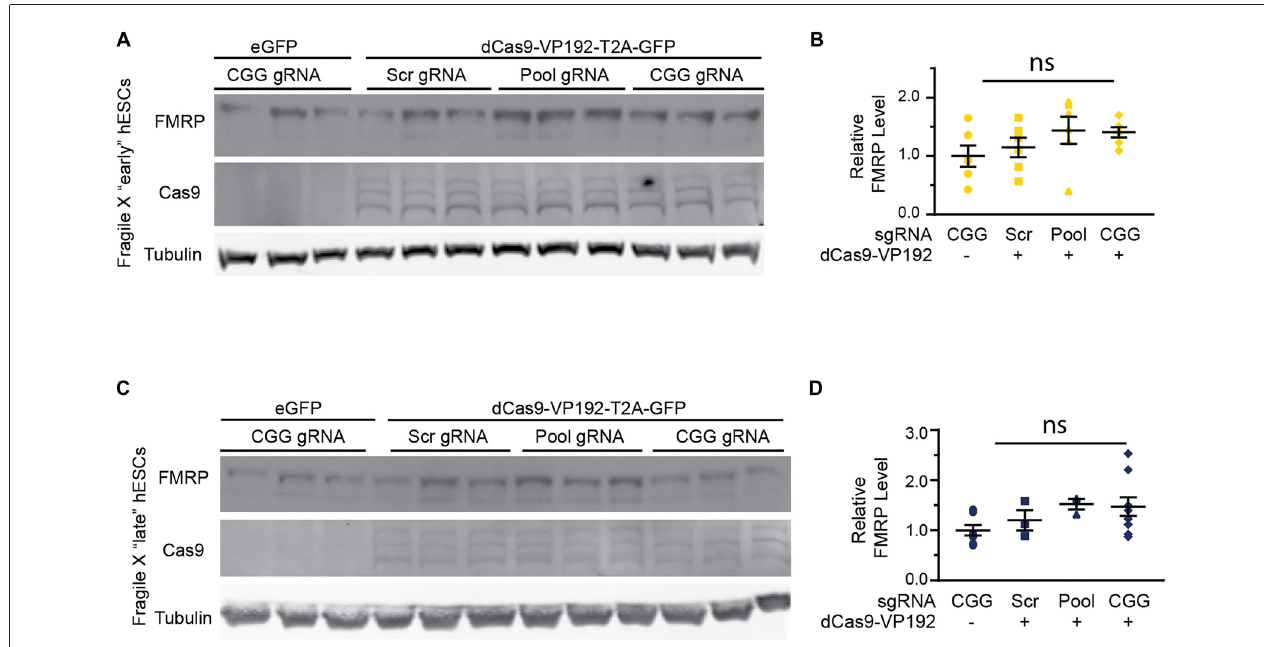
FIGURE 8 | Targeted reactivation of FMR1 does not significantly enhance FMRP expression in FXS hESCs. (A) Western blots showing triplicate samples of early (P25–28) passage FXS hESCs transfected with control plasmid (eGFP) or with dCas9-VP192 and gRNAs immunoblotted for FMRP (by Femto ECL), Cas9 and tubulin as a loading control. (B) Quantification of western blots from early passage FXS hESCs transfected as indicated. (C) Western blots showing triplicate examples of late (P47–64) passage FXS hESCs transfected as in (A) . (D) Quantification of western blots from late passage FXS hESCs transfected as indicated. For all scatter plots, each data point represents an individual well. Data were obtained from two (B) or three (D) independent experiments. The mean with error bars (SEM) is shown for each condition. ns, not